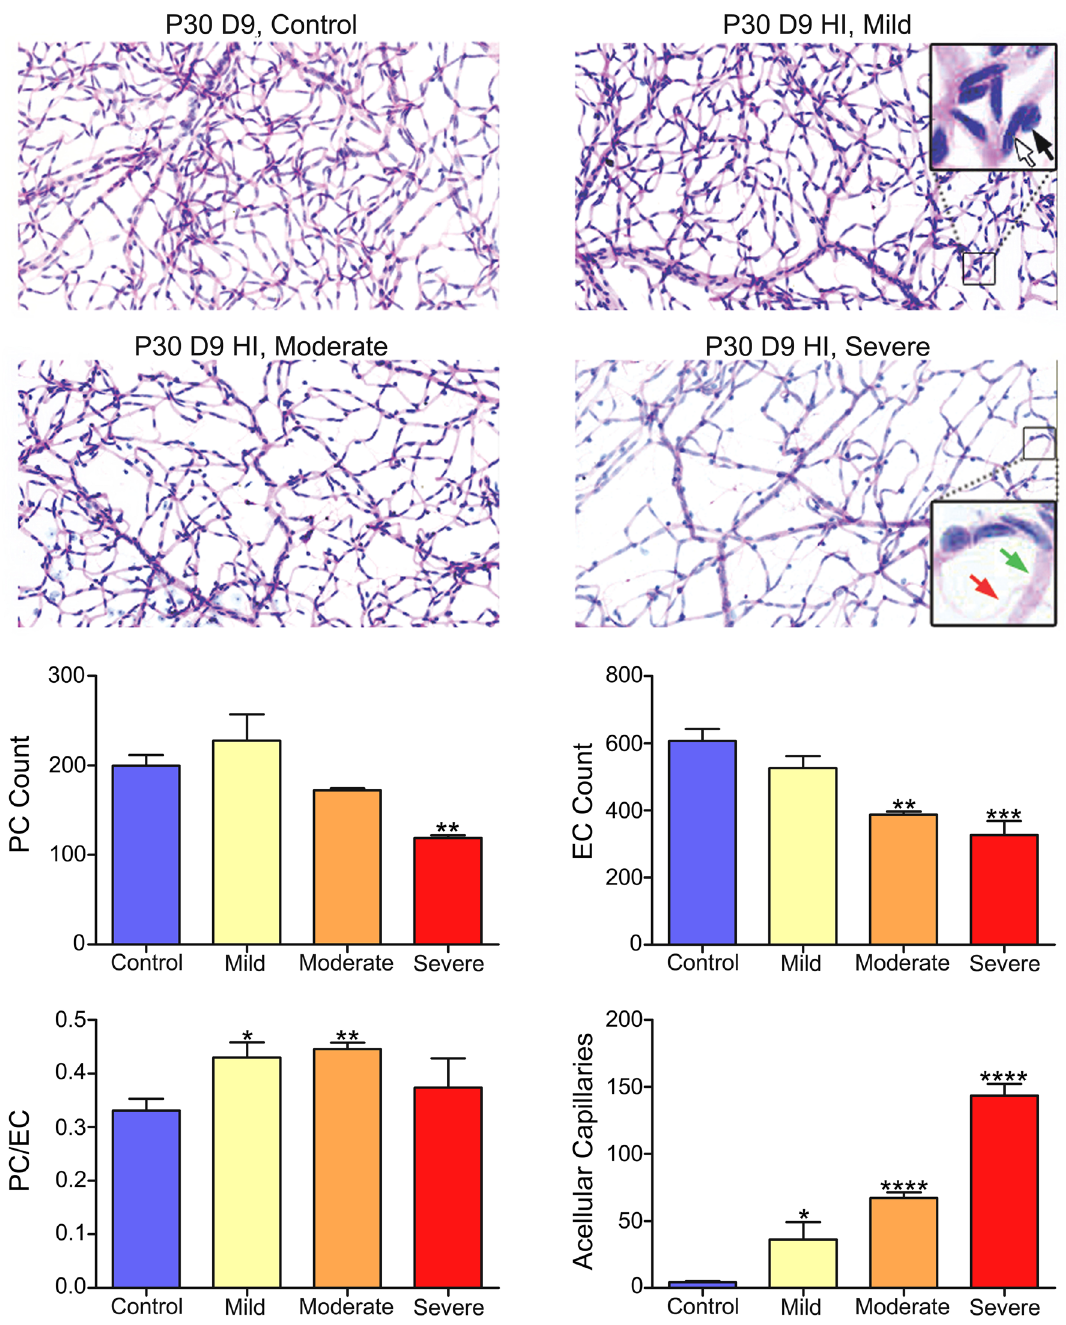
Figure 5. Vascular degeneration in juvenile mouse retina after exposure to HI as shown by trypsin digest preparations. Representative images were captured from the peripheral retinal vasculature of control (right), mild, moderate, and severe HI injured (left) eyes from P30D9 mice. The endothelial cells nuclei reside within the vessel wall along the capillary wall (white arrow); Nuclei of pericytes generally land on the outside of the capillary wall (black arrow). Number of pericytes, endothelial cells, the pericyte/endothelial (PC/EC) ratios, and the acellular capillaries (red arrow) are summarized. Data from 5 control eyes, 3 mildly injured eyes, 3 moderately injured eyes and 2 severely injured eyes were analyzed and presented herein. Data presented as mean ± SD. Preparations were imaged using the Aperio slide scanner and × 20 objective was